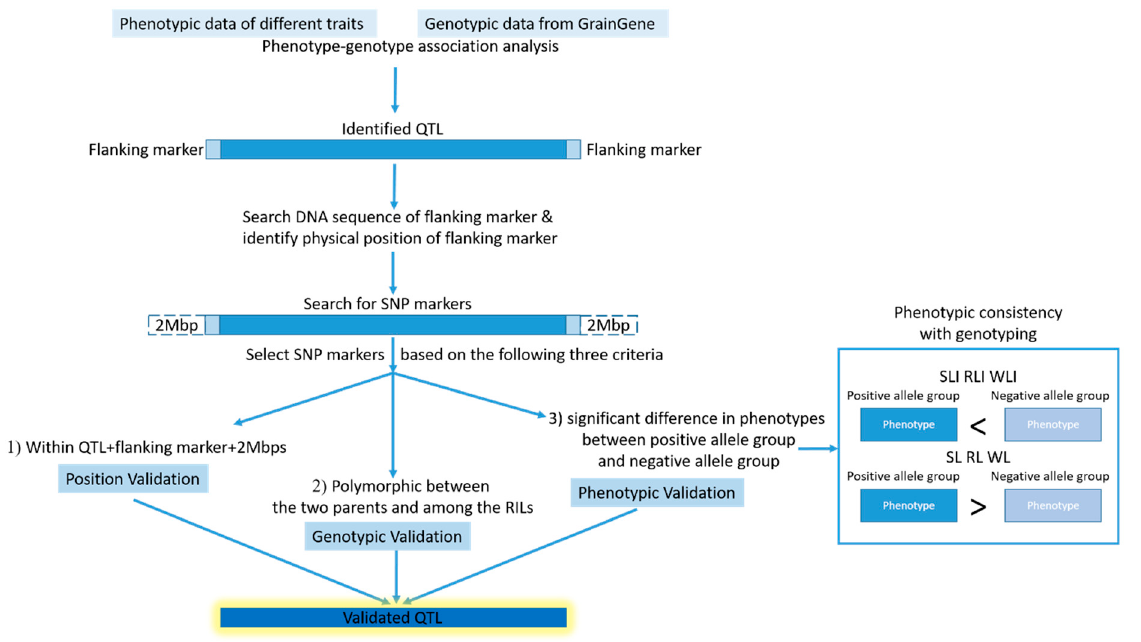
Figure 4. Protocol of validation for identified major QTL. The identified QTL was shown in dark blue and the flanking markers were shown in light blue. The searched area could be extended to 2 Mbp, showed by light blue dash lines. Phenotypic data of positive allele group were shown in dark blue and that of negative allele group was shown in light blue. The QTL validated by all the qualifications was shown by dark blue with yellow glow. SLI, RLI and WLI were shoot length, root length, and whole length index, respectively. SL, RL and WL were shoot length, root length, and whole lengths under 35 °C heat stress. SNP markers were searched by three selection criteria: (1) the SNP position was within the QTL interval or within 2 Mbp from each of the flanking markers, (2) the SNP was polymorphic between the two parents and thus among the RILs, and (3) the RILs possessing different alleles of the SNP showed significant difference in phenotypes.